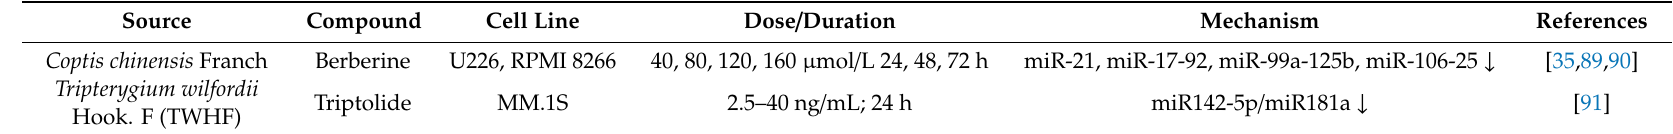
Table 6. miRNA regulating natural products.